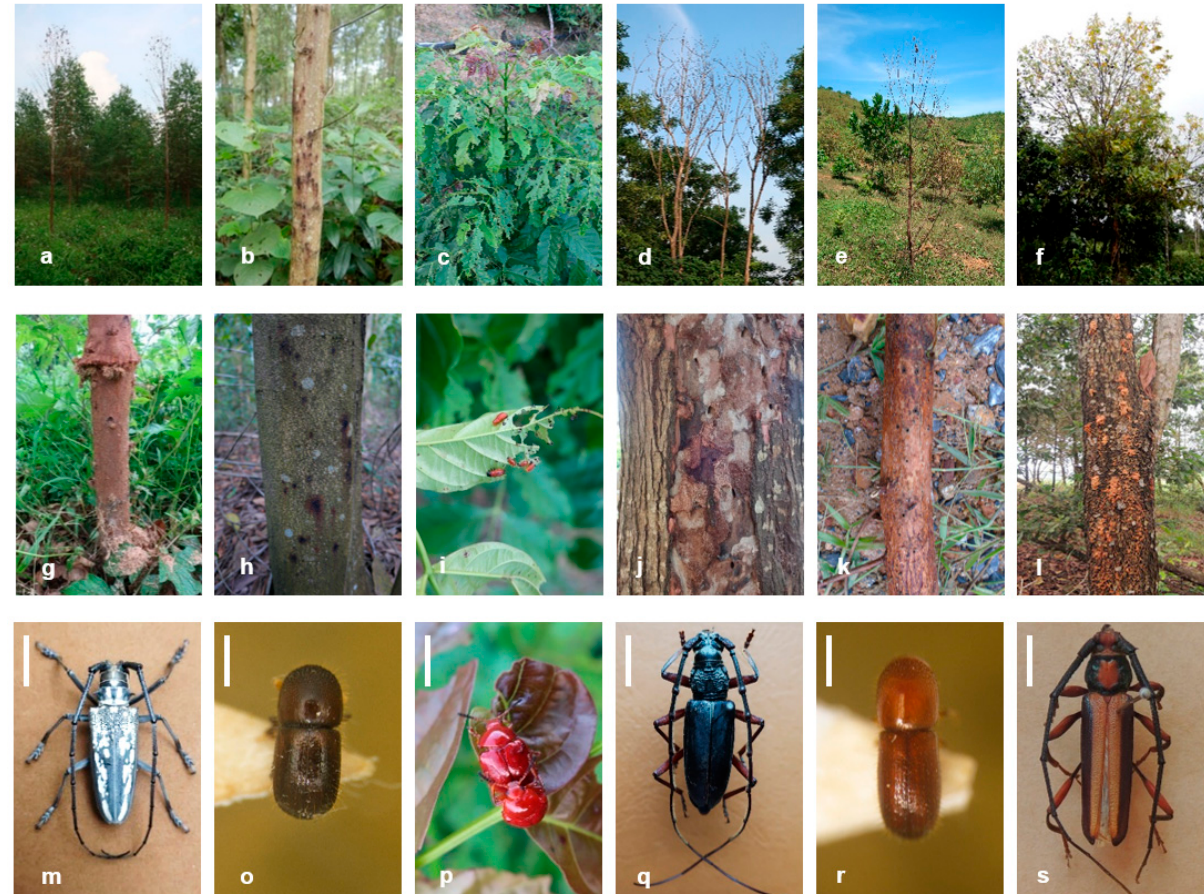
Figure 4. Wood borer and beetle damage to forest plantations in Vietnam. ( a – f ) damaged trees; ( g – l ) close-up of damage symtoms; ( m – s ) adults. ( a , g , m ) Batocera lineolata damage in Eucalyptus hybrid; ( b , h , o ) Euwallacea fornicatus damages in Acacia hybrid; ( c , i , p ) Lycaria westermanni damage in Fernandoa brilletii ; ( d , j , q ) Tapinolachnus lacordairei damage in Chukrasia tabularis ; ( e , k , r ) Xyleborus perforans damage in Eucalyptus urophylla ; ( f , l , s ) Xystrocera festiva damage in Acacia mangium . Scare bar: m = 1.5 cm, o = 1.0 mm; p , q , s = 1.0 cm; r = 1.2 mm.